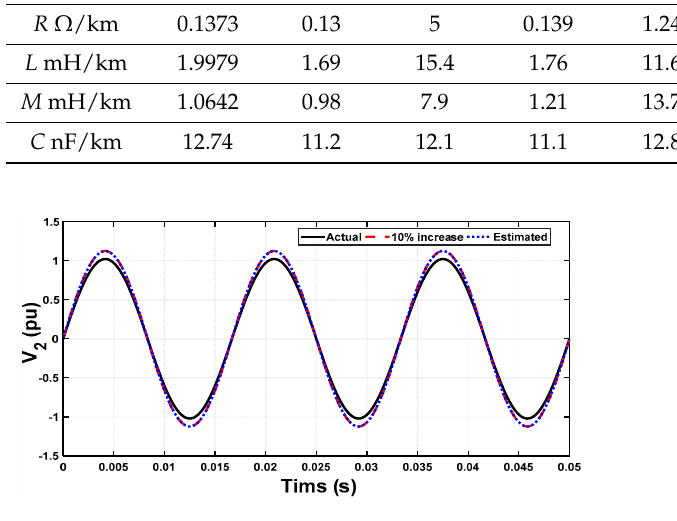
Table 3. Actual and estimated parameters with ±10% magnitude error in V 2 and I 2 and 20% syn-